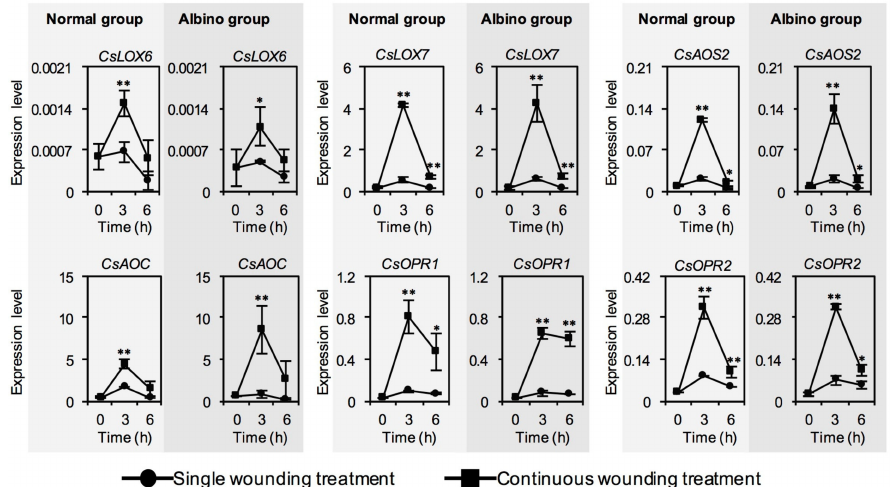
Figure 4. Changes in expression level of jasmonic acid (JA) biosynthetic genes of normal tea leaves and albino tea leaves exposed to single wounding treatment and continuous wounding treatment, respectively. Data are expressed as mean ± SD ( n =3). * p ≤ 0.05; ** p ≤ 0.01, comparison between single wounding treatment and continuous wounding treatment at the same treatment time. LOX , lipoxygenase ; AOS , allene oxide synthase ; AOC , allene oxide cyclase ; OPR , 12-oxo-phytodienoic acid reductase